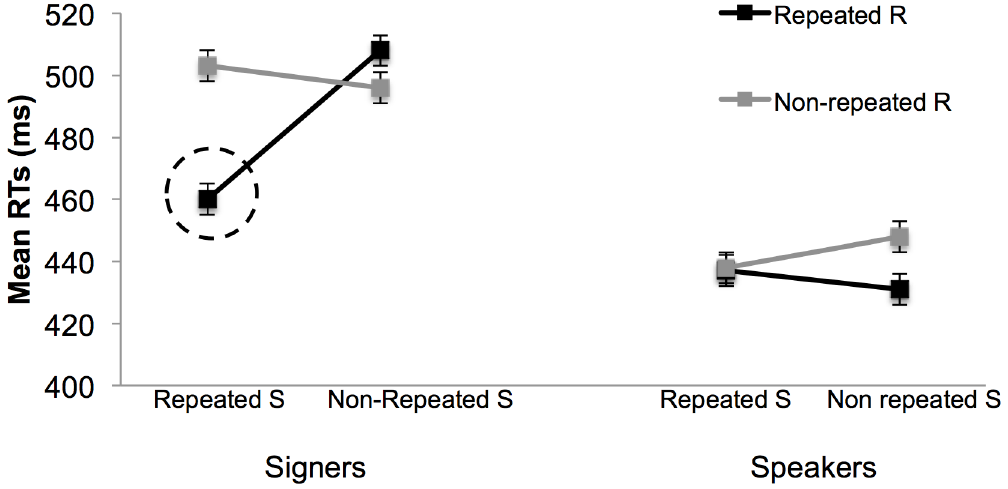
Fig 4. Effects of stimulus (S) and response (R) repetition in N-1 non-corresponding trials (hand condition). Signers were especially fast when stimuli and responses were jointly repeated between consecutive trials.